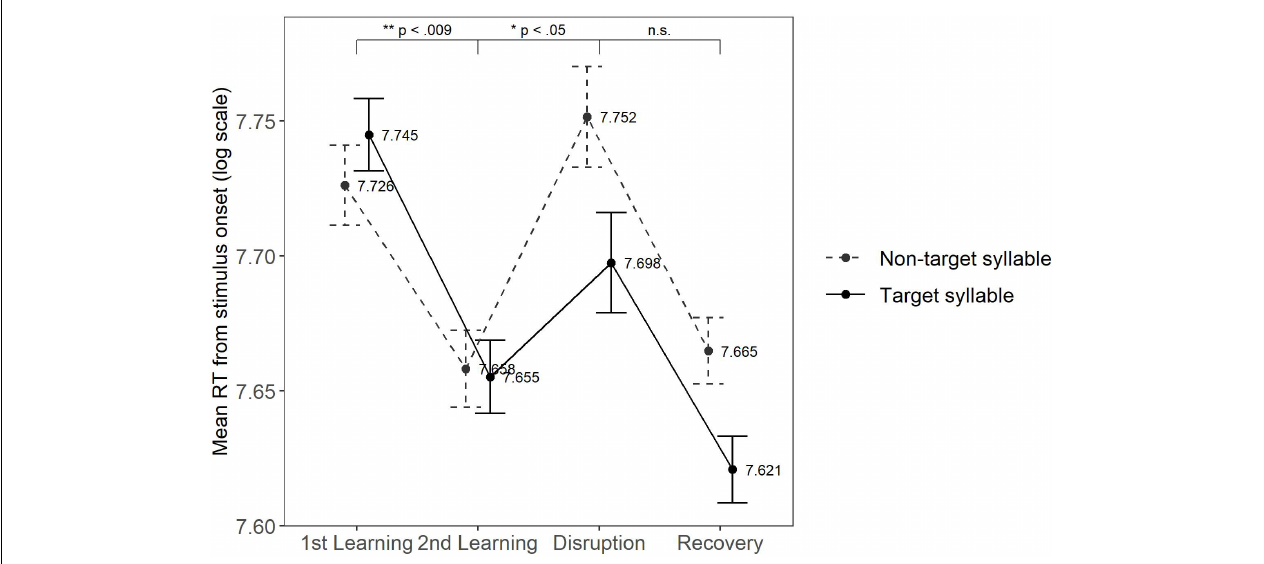
FIGURE 2 | Mean response times from stimulus onset (RTs in log-scale) and error bars with SEs for the target (solid) and non-target (dashed) syllable across the four blocks of exposure. The numerical values for the means are annotated. ∗ Indicates statistical significance, as indicated by the p -value.